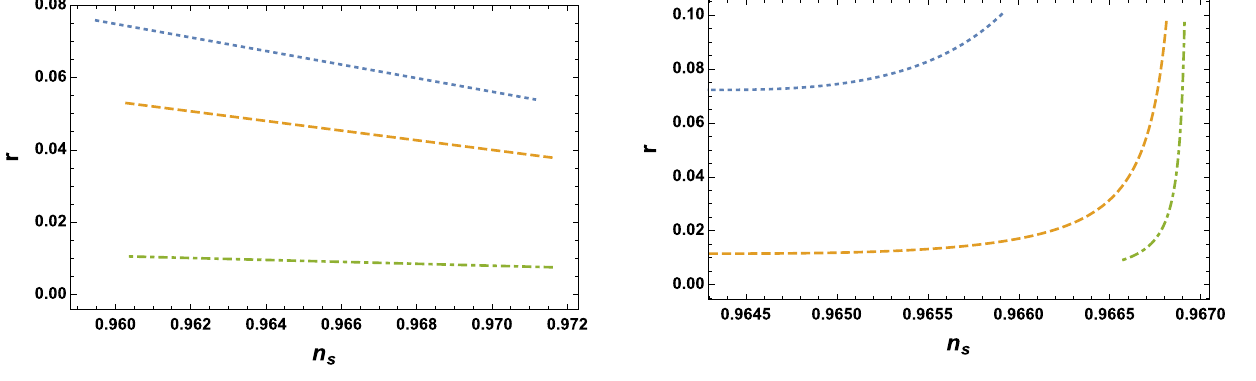
Fig. 13 n s vs r for N = 60 and λ = 2 (dotted), λ = 5 (dashed) and λ = 10 (dot-dashed) with η in the interval 0 . 1 ≤ η ≤ 0 .